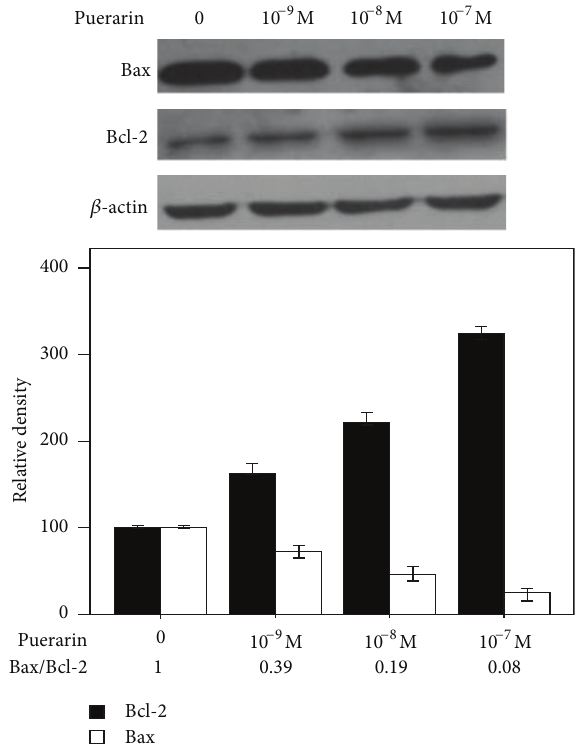
Figure 3: Effects of puerarin on the expression of Bcl-2 and Bax in hOBs. Cells were treated with 0, 10 −9 M, 10 −8 M, and 10 −7 M puerarin for 48h before collecting proteins. Cell lysates were subjected to western blot analysis and incubated with anti-Bax, anti-Bcl-2, or anti- 𝛽 -actin monoclonal antibodies. Gel-Pro 4.0 gel image analysis software was used to analyze the absorbance values of Bcl-2 and Bax. Figure 4: Effects of puerarin on ERK signaling pathways in hOBs. Anti-ERK and anti-p-ERK monoclonal antibodies were used to perform in western blotting. Cells were exposed to 10 −8 M puerarin for 0–45min. The levels of ERK and p-ERK were measured by densitometry of autoradiographs.